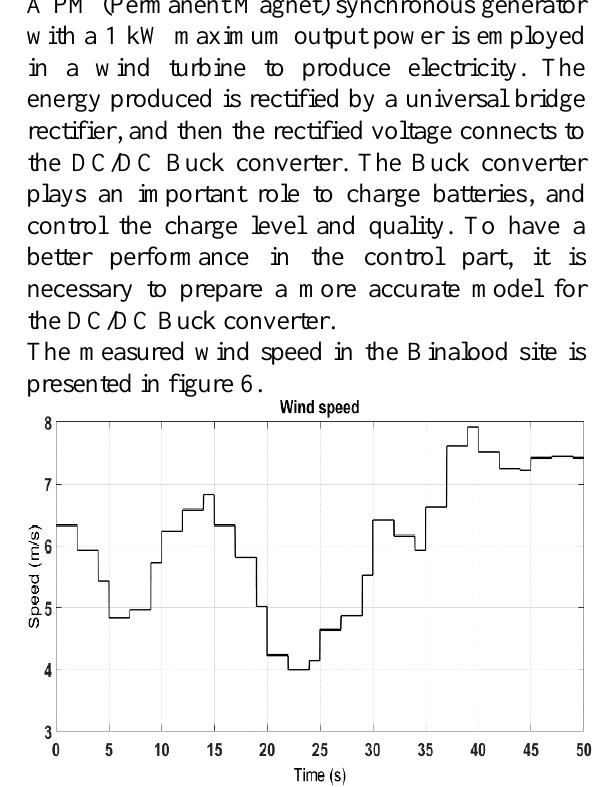
Figure 6. Measured wind speed in Binalood site.